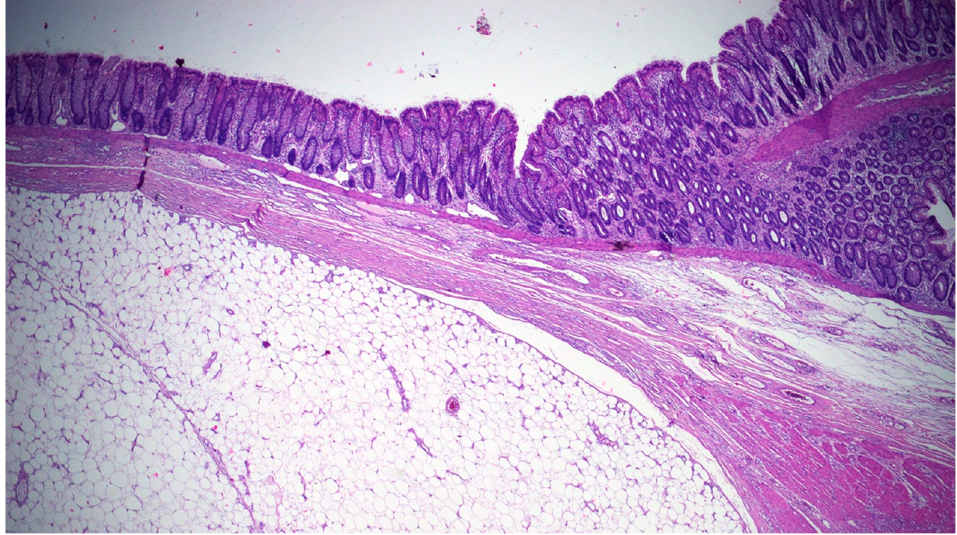
Figure 4. Scanning view showing a well-circumscribed submucosal lesion consisting of mature adipose tissue, surrounded by a rim of muscularis mucosa, and covered by unaltered mucosa.